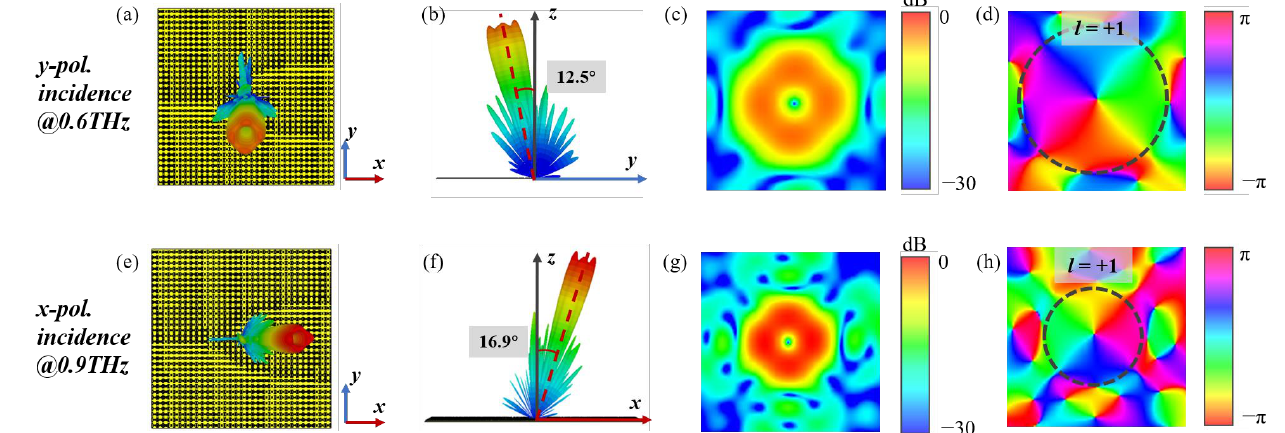
Figure 4. Full-wave simulated scattering field diagrams of the single vortex beam metasurface. ( a ) Top view and ( b ) side view of the 3D far-field simulation scattering diagrams; ( c ) magnitude and ( d ) phase of the 2D far-field partial diagrams of the l 1 = + 1 deflected vortex beam at 0.6 THz under the y -polarized incidence. ( e ) Top view and ( f ) side view of the 3D far-field simulation scattering diagrams; ( g ) magnitude and ( h ) phase of the 2D far-field partial diagrams of the l 2 = + 1 deflected vortex beam at 0.9 THz under the x -polarized incidence.